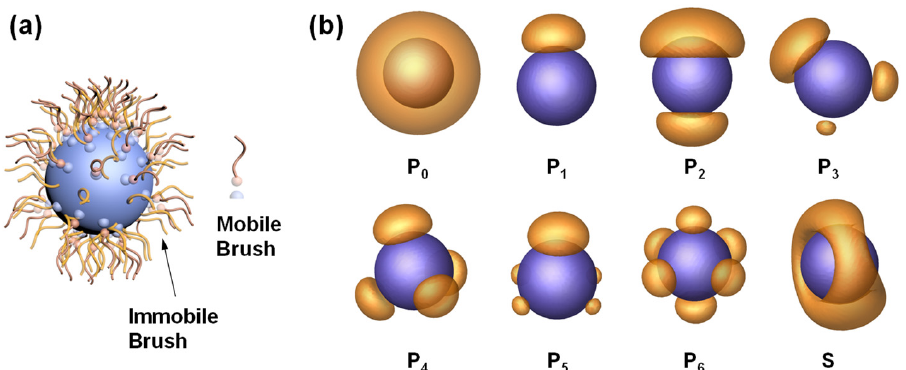
Figure 1. ( a ) Schematic illustration of a PFN consisting of mobile and immobile brushes. ( b ) Representative patterns formed by phase separation of polymers tethered on nanoparticles. P n denotes the n-patch nanoparticle; that is, P 0 is a zero-patch nanoparticle, P 1 is a one-patch nanoparticle, and so forth. S denotes the striped nanoparticle.